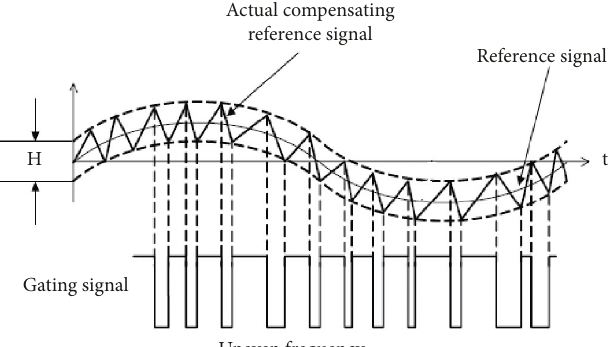
Figure 19: Gating pulse for